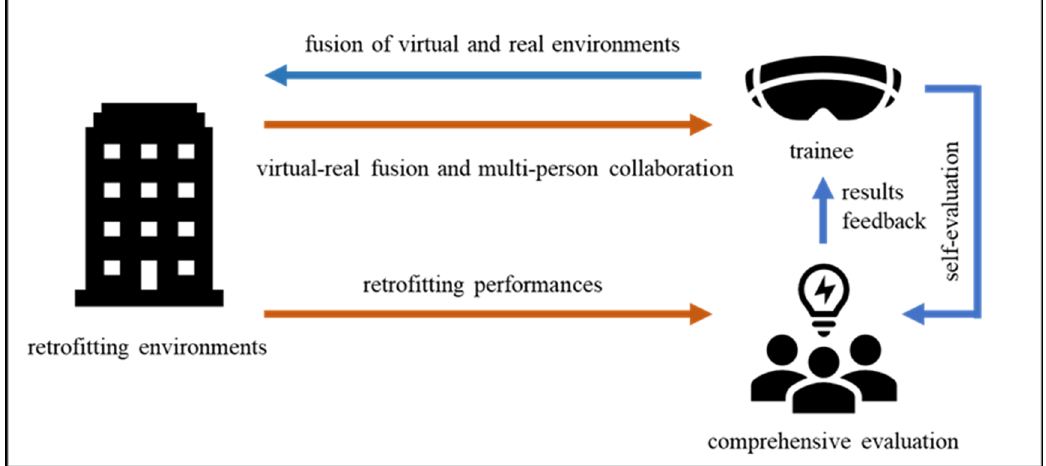
Figure 2. The evaluation data process of the MR seismic retrofitting training system.